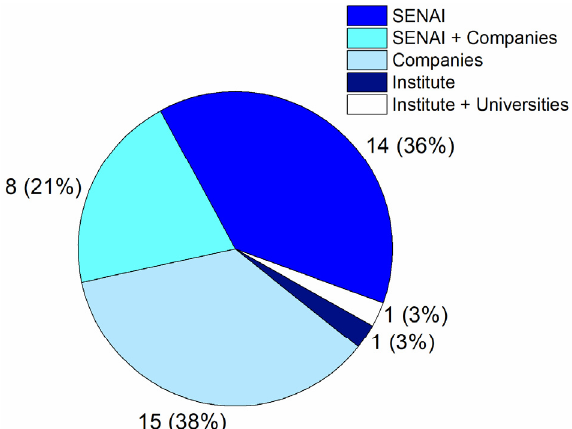
Figure 6. Distribution of institutions by maintenance unit. Among 39 maintenances units, SENAI institutes were involved in 59%.